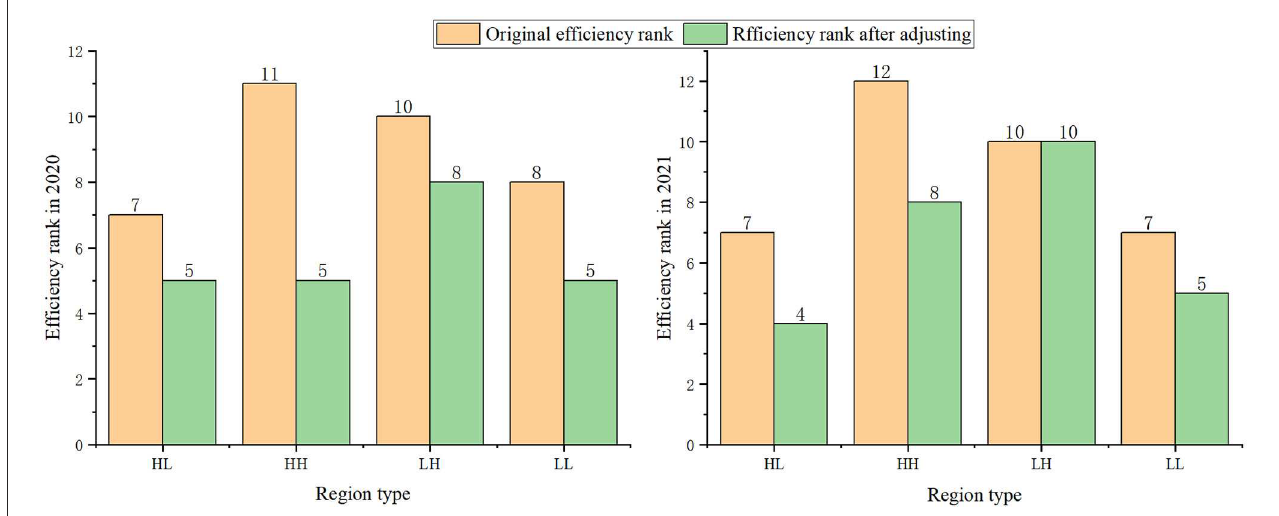
FIGURE4 The impact of COVID-19 on green technological innovation in different